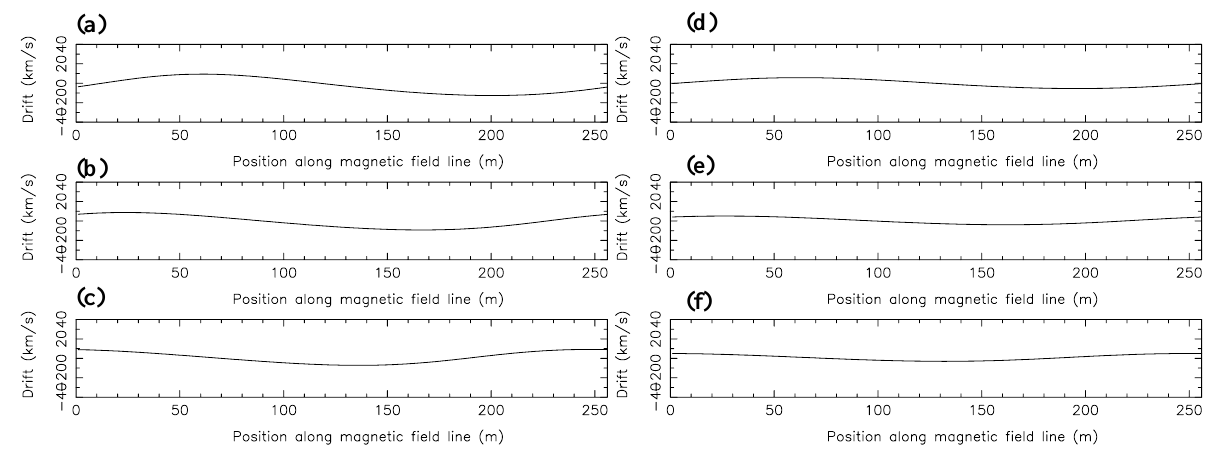
Fig. 11. The mean (parallel) electron drift as a function of position along the magnetic field: (a) n ≡ 20% and V p =40km/s; (b) n ≡ 20% and V p =20km/s; (c) n ≡ 20% and V p =0km/s; (d) n ≡ 10% and V p =40km/s; (e) n ≡ 10% and V p =20km/s; (f) n ≡ 10% and V p =0km/s.